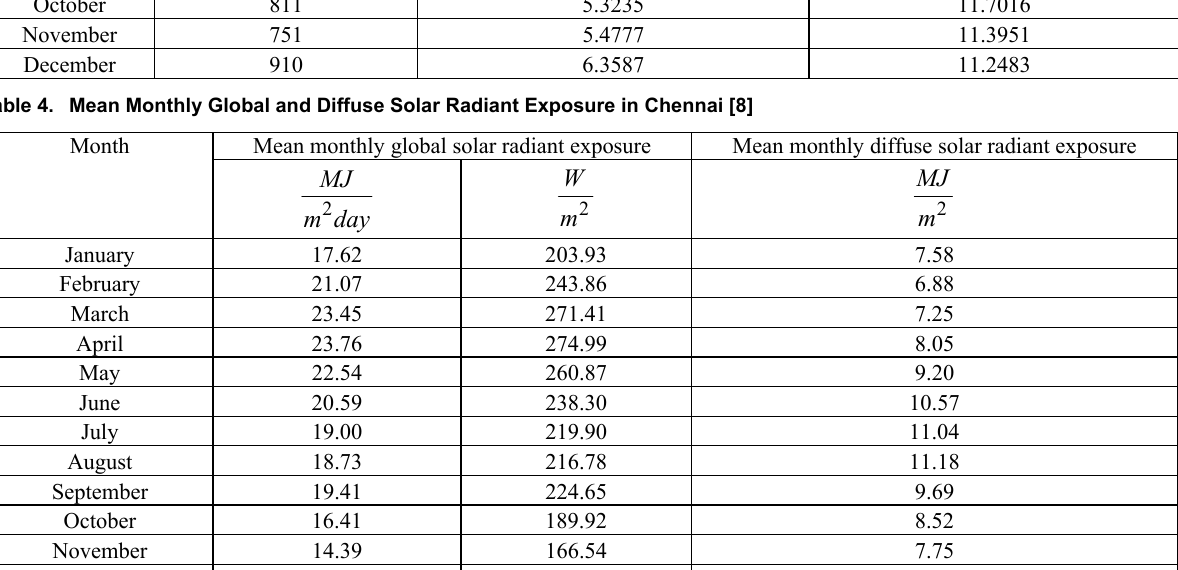
Table 4. Mean Monthly Global and Diffuse Solar Radiant Exposure in Chennai [8] Month Mean monthly global solar radiant exposure Mean monthly diffuse solar radiant